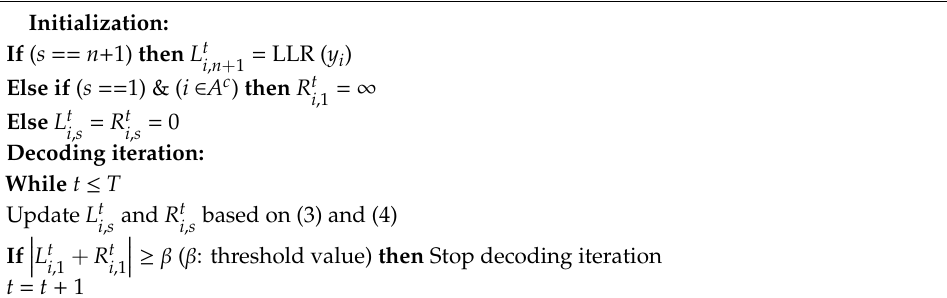
Algorithm 1: Threshold-based [15] early-termination technique